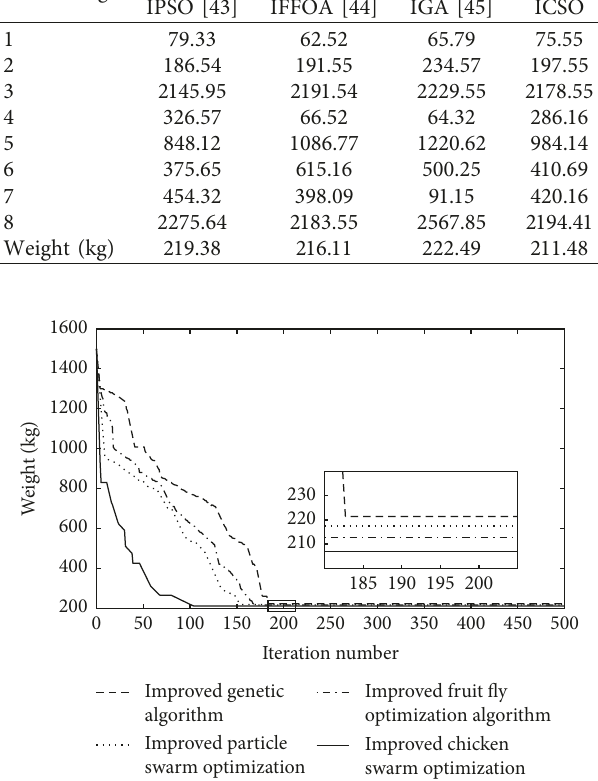
Figure 8: Four algorithms for finding the iterative curve of 25bars.